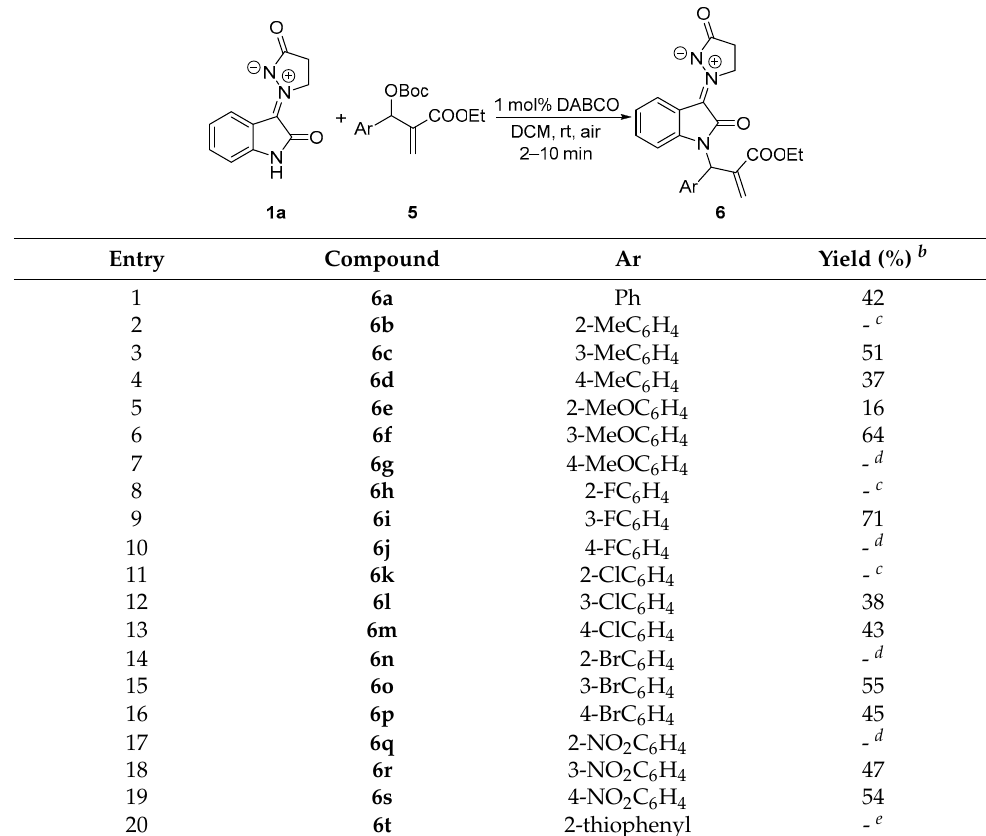
Table 3. Synthesis of N -allylated products 6 from isatin N , N ′ -cyclic azomethine imine 1 and MBH carbonates 5 a .